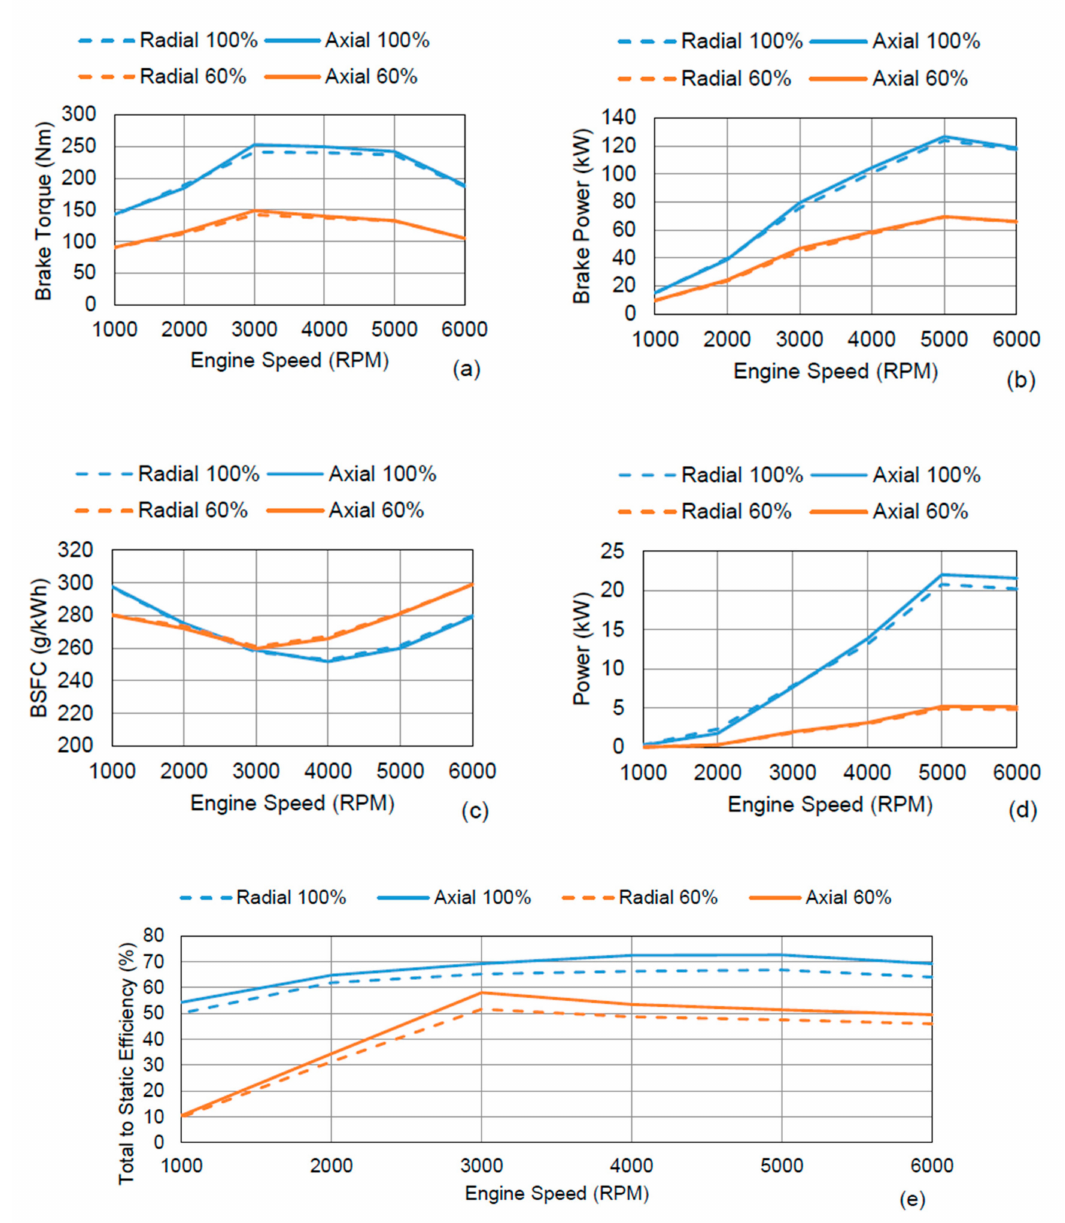
Figure 29. Comparison of ( a ) engine brake torque, ( b ) engine brake power, ( c ) engine BSFC, ( d ) turbine power, and ( e ) turbine e ffi ciency between radial and axial turbines at di ff erent engine operating